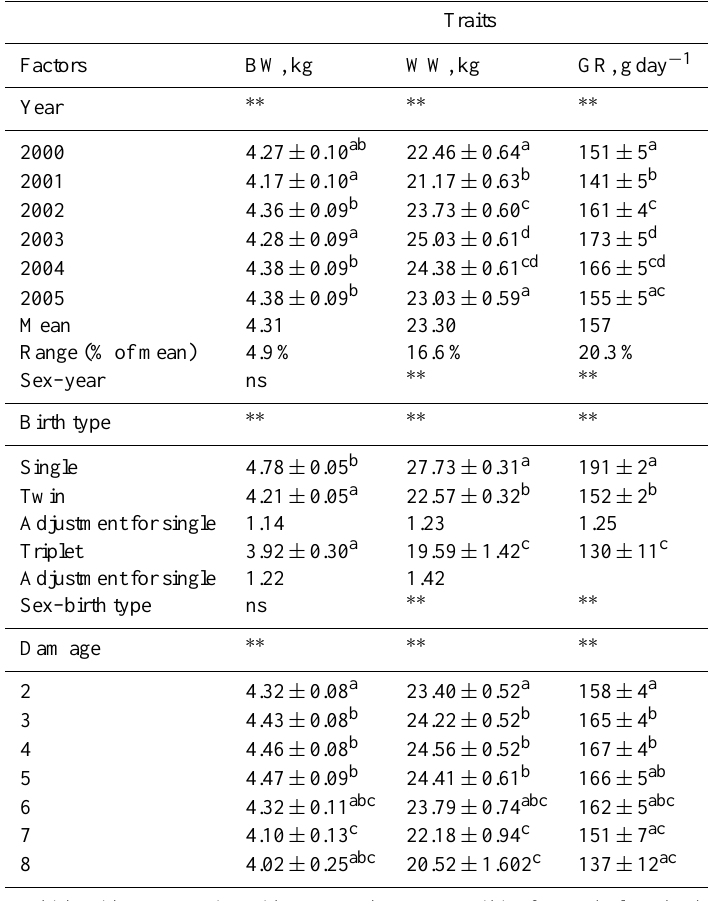
Table 4. Least-squares means ± SE of growth traits in female Afshari